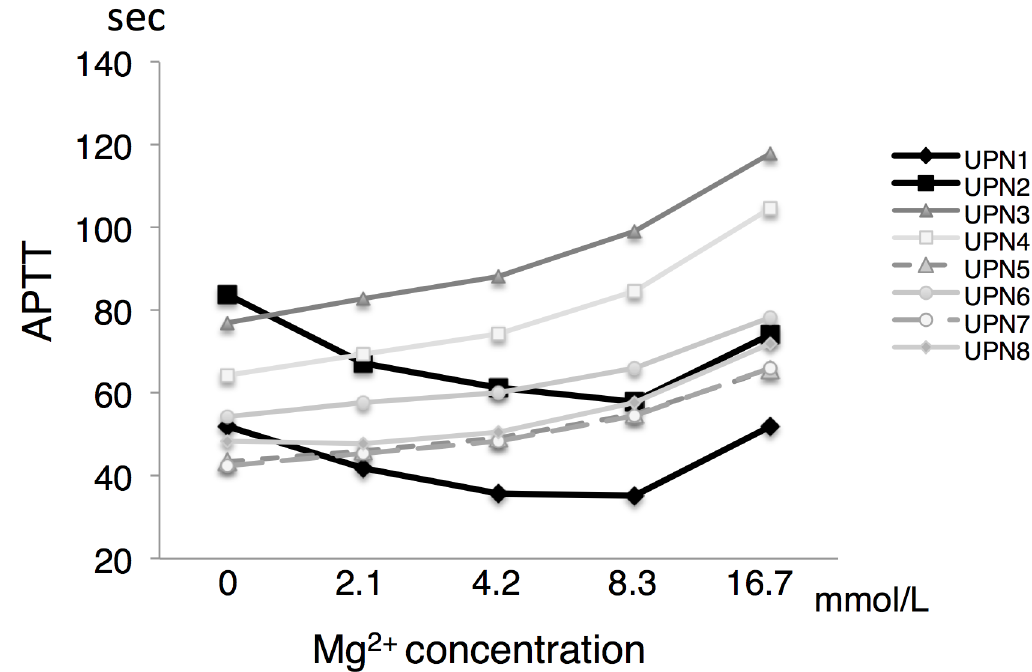
Fig 2. Effects of Mg 2+ on the APTT of patients with prolonged APTT. The unique patient numbers (UPN) correspond to those shown in the table.